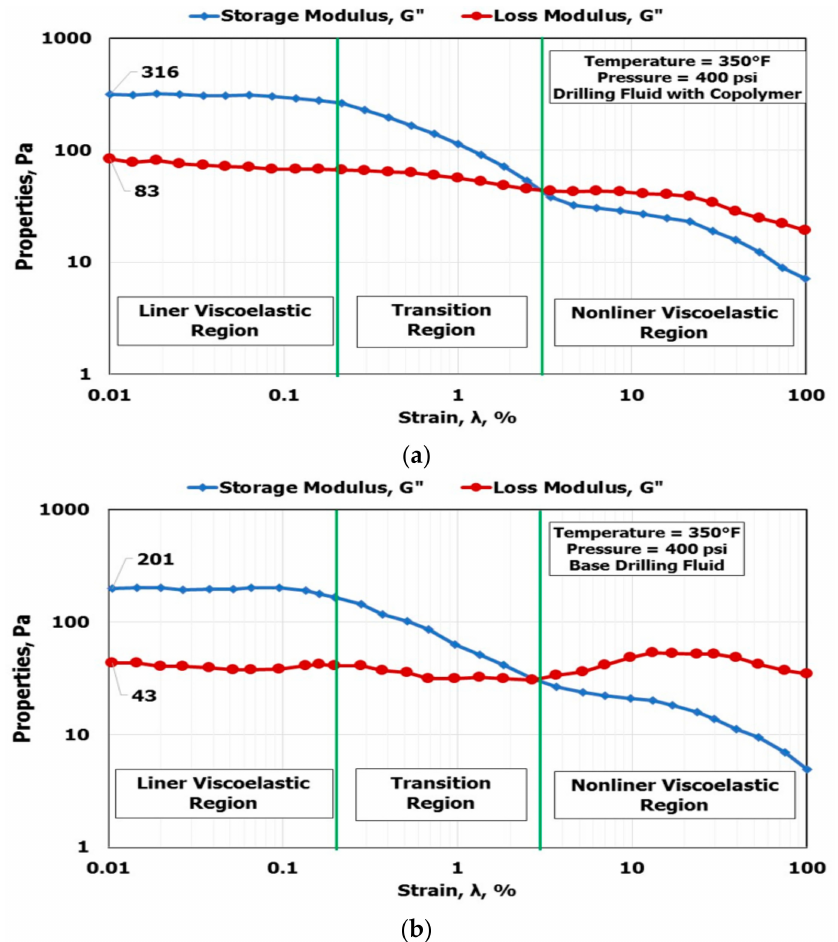
Figure 6. Storage and shear moduli at different stain for ( a ) drilling fluid with the copolymer and ( b ) base drilling